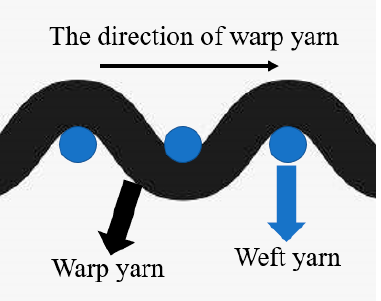
Figure 12. Cross-section along the warp yarn direction.